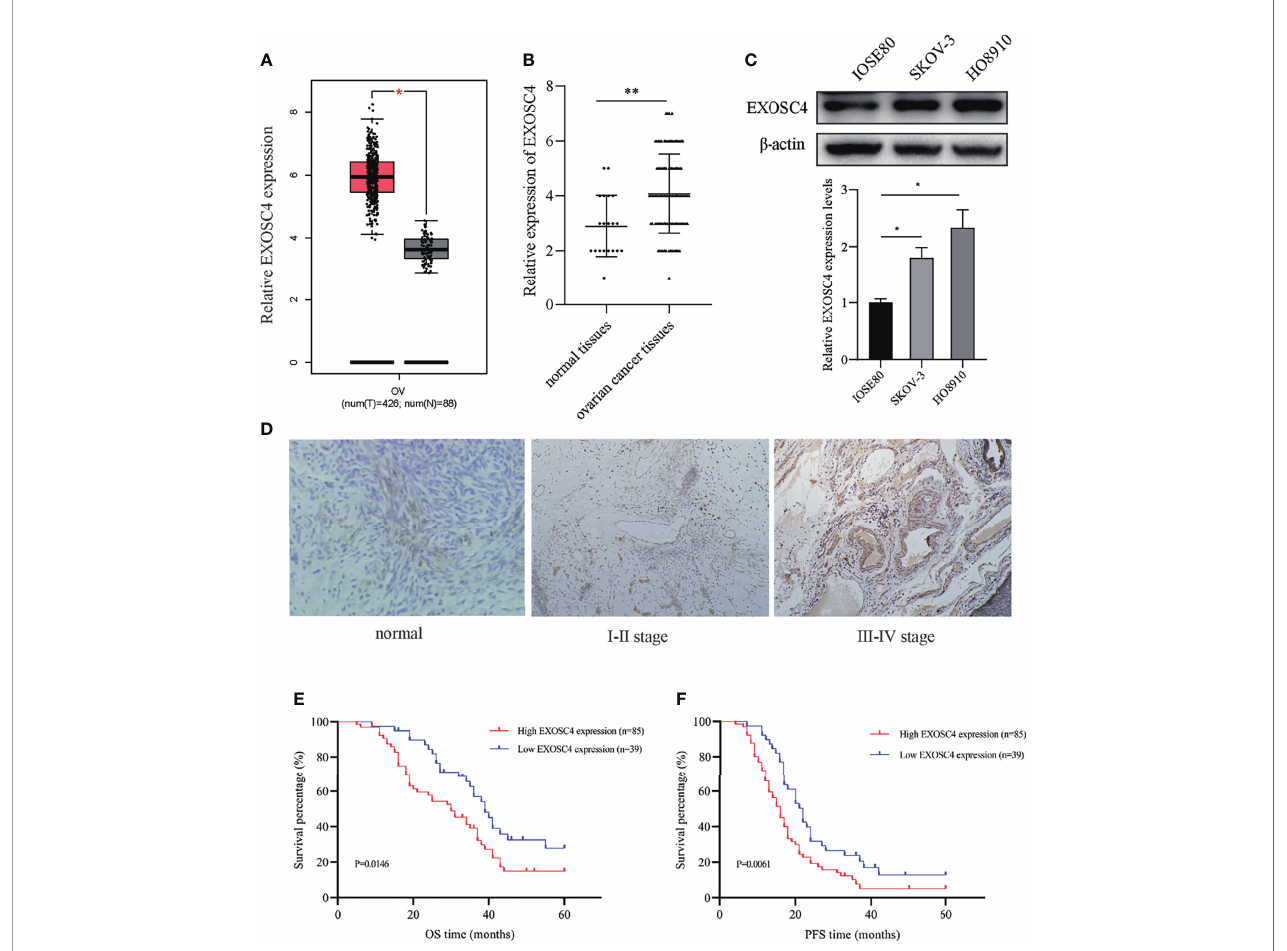
FIGURE 1 | Elevated EXOSC4 was observed in EOC tissues and cell lines, and predicted poor outcomes. (A) EXOSC4 expression levels in EOC tissues compared with normal tissues in TCGA and GTEx datasets. (B) Comparison of EXOSC4 expression levels between EOC and normal ovarian tissues using IHC. (C) EXOSC4 expression levels in EOC cell lines (SKOV-3 and HO8910) and a human ovarian cell line (IOSE80) were detected by western blot assay, and its band quanti fi cation. (D) Representative IHC of EXOSC4 expression in normal ovarian epithelial and ovarian cancer tissue samples at different FIGO stages. Original magni fi cation, × 100. (E) Kaplan-Meier curves for OS time in patients with EOC according to EXOSC4 levels. (F) Kaplan-Meier curves for PFS time in patients with EOC according to EXOSC4 levels. *p < 0.01, **p <